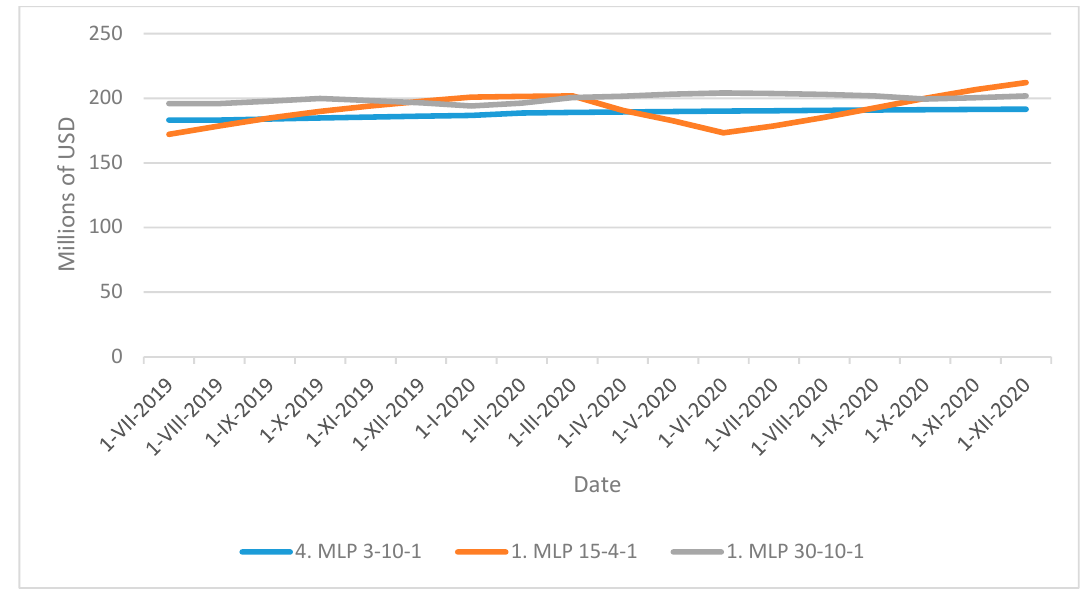
Figure 8. Comparison of the most suitable neural network structures from all experiments. Source: Authors.